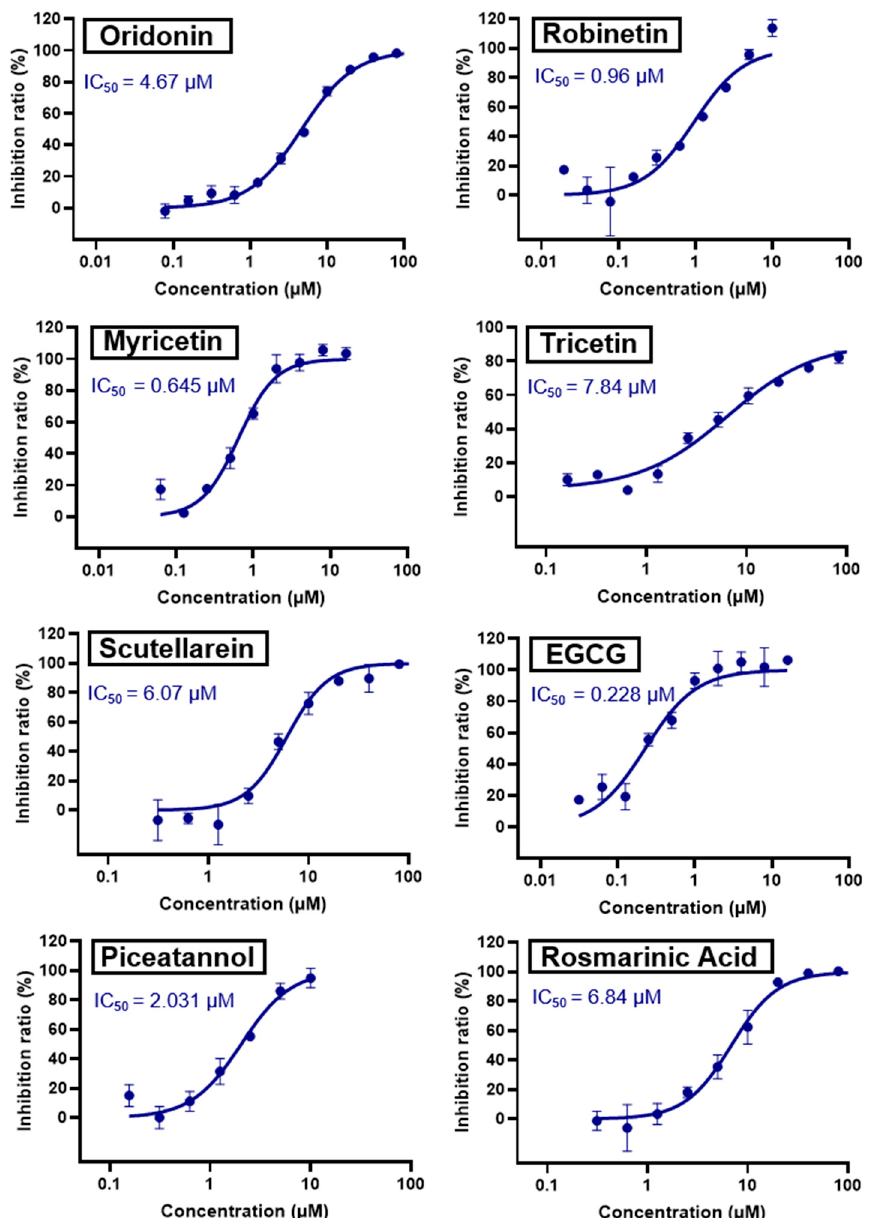
Figure 8. Concentration-dependent inhibition of SARS-CoV-2 M pro by the best inhibitors of the present series: Oridonin, robinetin, myricetin, tricetin, scutellarein, L-epigallocatechin gallate, piceatannol, rosmarinic